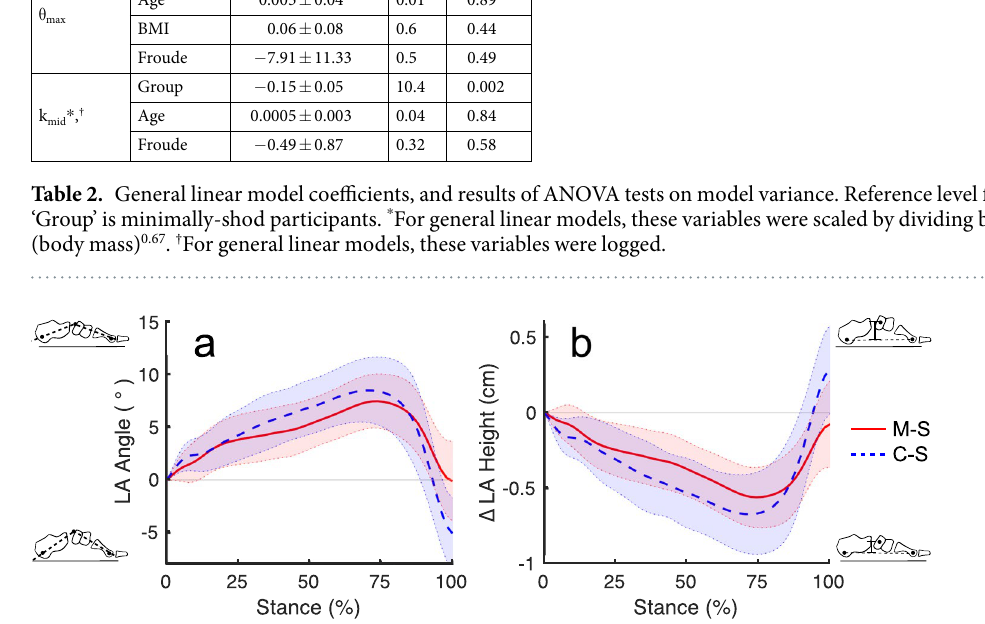
Figure 5. Average foot kinematics during stance phase. ( a ) LA angle and ( b ) Δ LA height during in minimally- shod (M-S; solid line) and conventionally-shod (C-S; dashed line) participants. Shaded regions represent ± one standard deviation. 0° and 0 cm height are defined by marker positions at foot